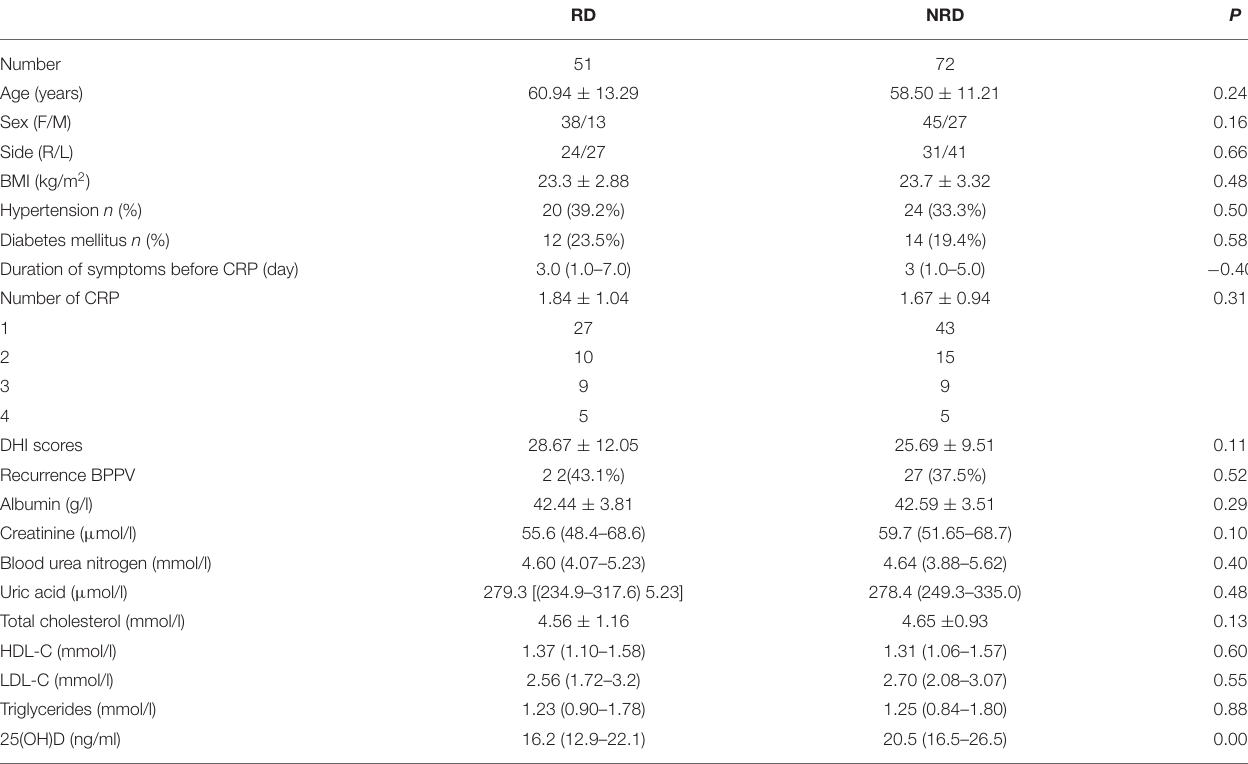
TABLE 1 | Demographical and clinical features of PC-BPPV patients with and without RD.